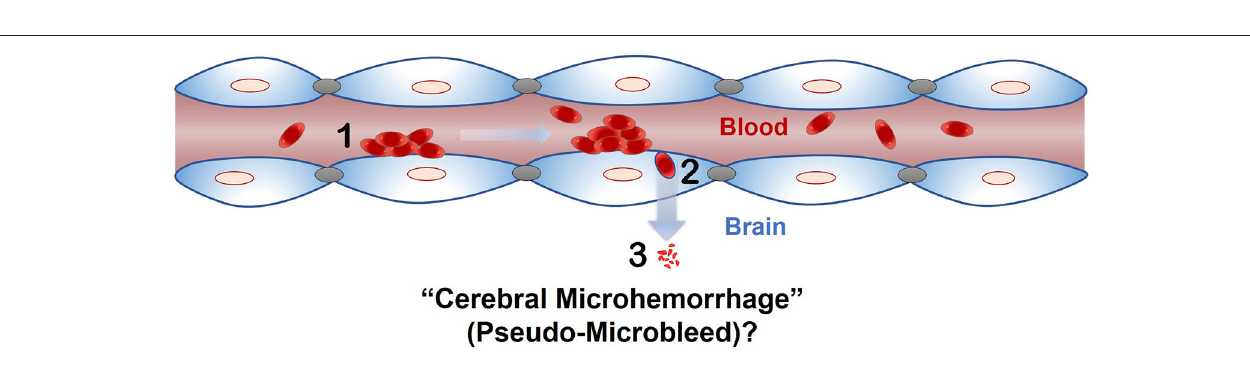
FIGURE 6 | Proposed role of endothelial erythrophagocytosis in cerebral microhemorrhage (pseudo-microbleeds) development. Aged and/or injured RBC adhere to (1) and are engulfed by (2) the brain endothelium. Iron rich RBC or degradation products (e.g., hemoglobin) are translocated across the brain endothelium (3), where they may produce signatures of